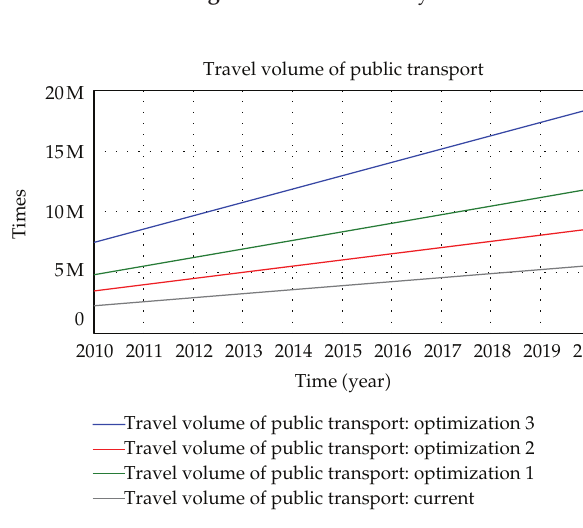
Figure 7: Tra ffi c intensity.